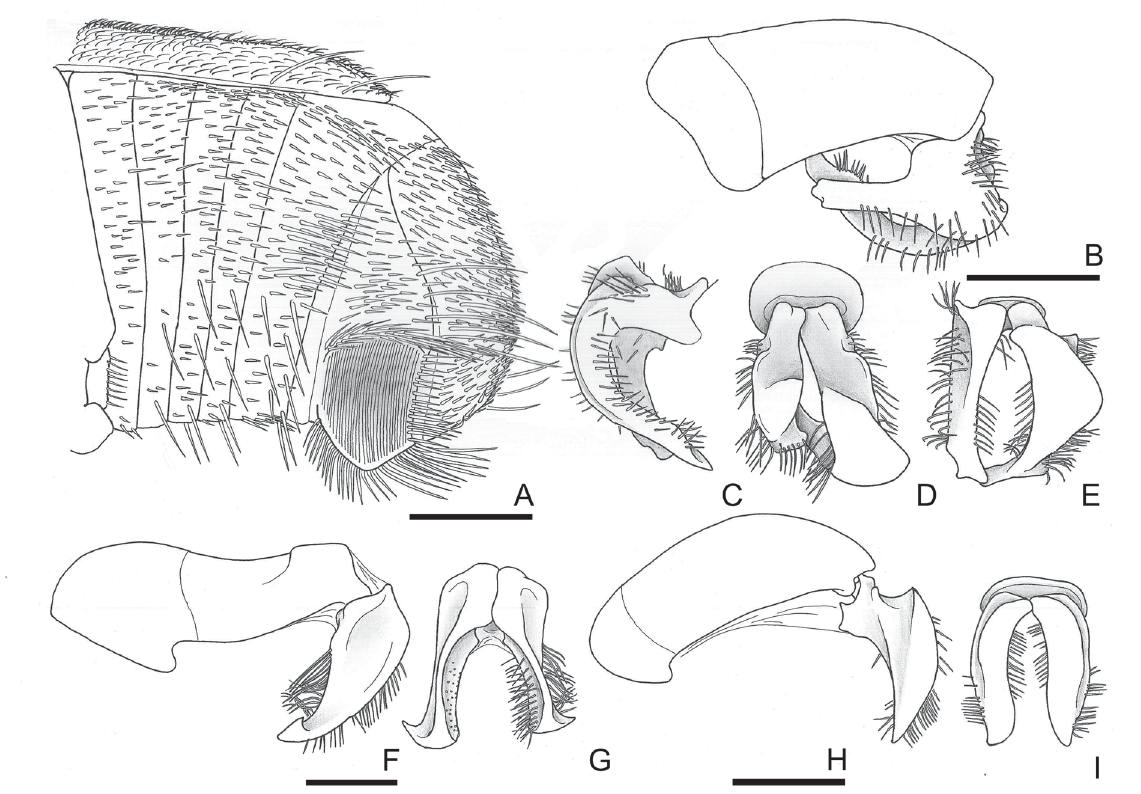
Fig. 9. A . Lateroventral detail of male abdomen. B , F , H . Aedeagus, lateral. C . Left paramere. D , G , I . Parameres, apex. E . Parameres, ventral. A−E . Chariodema virescens Blanchard, 1842. F−G . Ceraspis bivulnerata (Germar, 1824). H−I . Faula cornuta Blanchard, 1850. Scale bars = 1